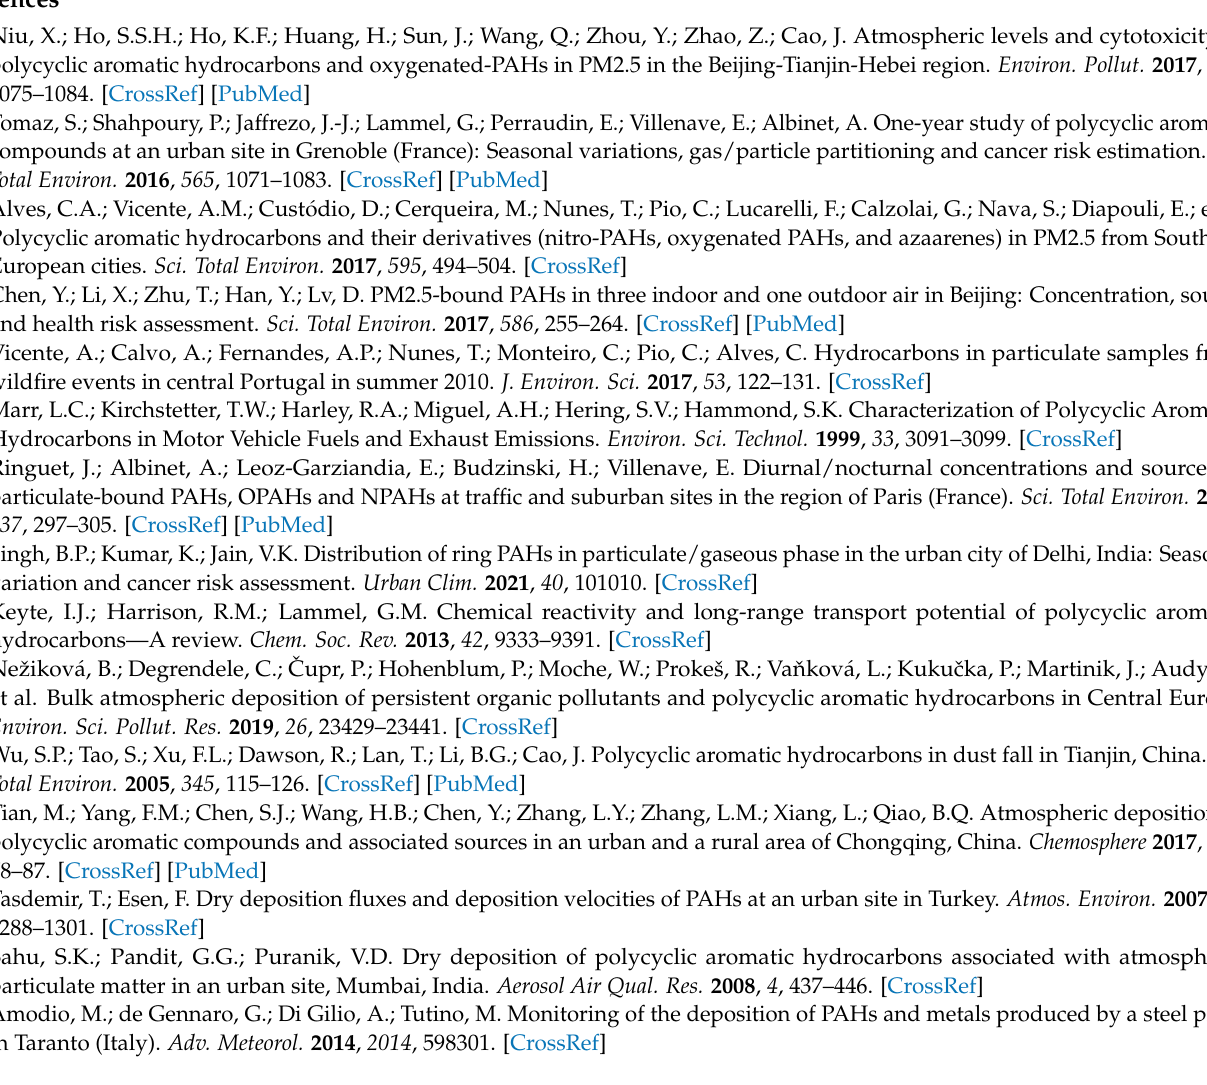
Poland; Figure S2: An example of 24-h backward trajectory simulation over the study domain; Figure S3: Daily variability of deposition fluxes of low-, medium-, and high-molecular-weight PAHs during the PM2.5 measurements in 2019; Table S1: Statistical parameters for PM 2.5 mass concentration and meteorological variables in Gdynia,